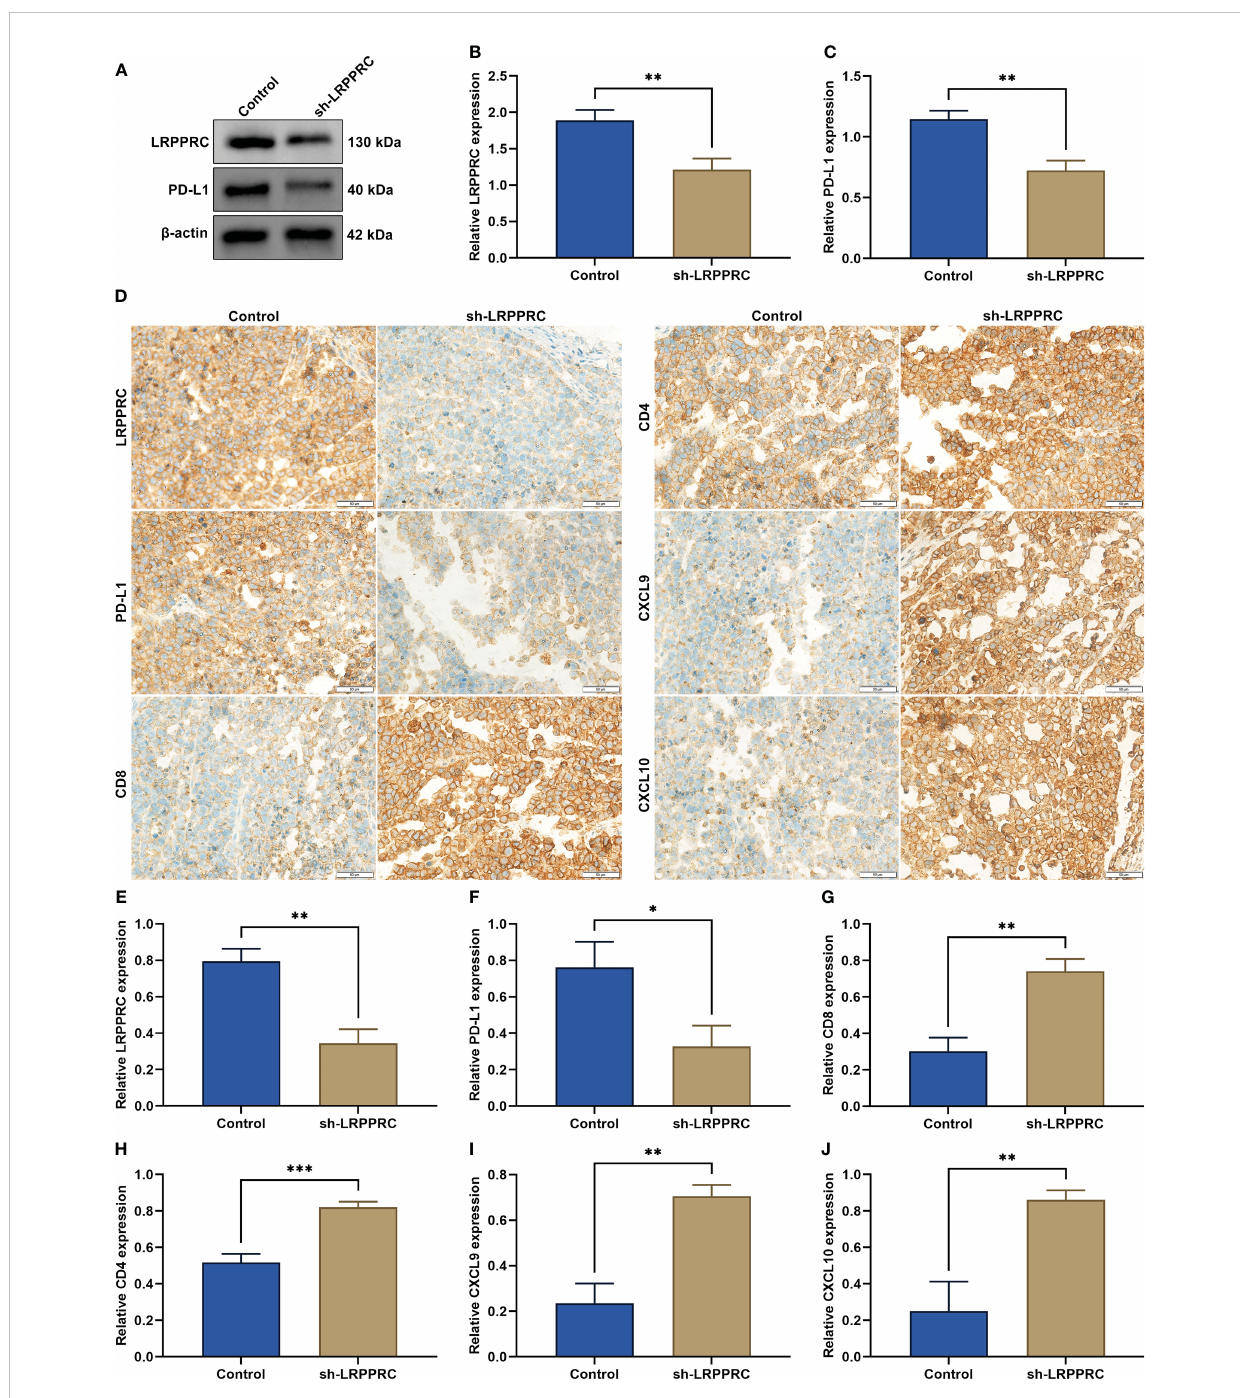
FIGURE 8 Leucine rich pentatricopeptide repeat containing (LRPPRC) loss improves anti-tumor immunity and immune in fi ltration in vivo . (A – C) Immunoblotting of LRPPRC and PD-L1 expression in tumors from BALB/c nude mice injected with LRPPRC-knockout or not 2 × 10 5 HepG2 cells. (D) Representative immunohistochemical staining photographs of LRPPRC, PD-L1, CD8, CD4, CXCL9, and CXCL10 in tumor specimens. Bar, 50 m m. (E – J) Quanti fi ed data of (E) LRPPRC, (F) PD-L1, (G) CD8, (H) CD4, (I) CXCL9, and (J) CXCL10 in tumors in accordance with immunohistochemical staining. * p < 0.05; ** p < 0.01; *** p <